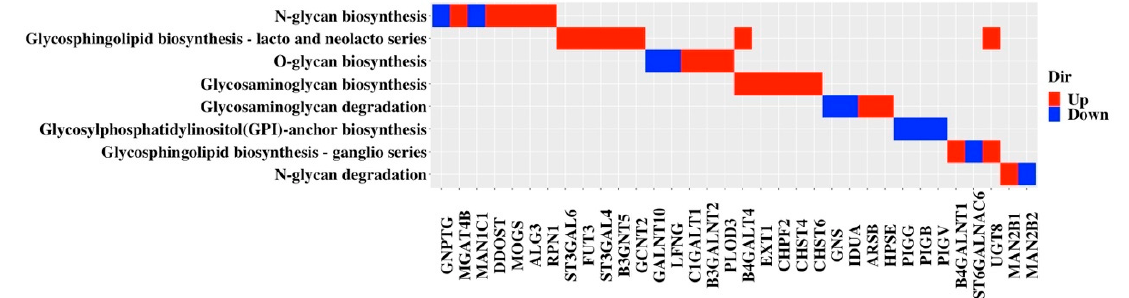
Figure 6. Glycosylation pathways for the 34 candidate TNBC glycogenes. Genes up-regulated in TNBC compared to non-TNBC/normal are labelled as red, while down-regulated genes are labelled as blue.